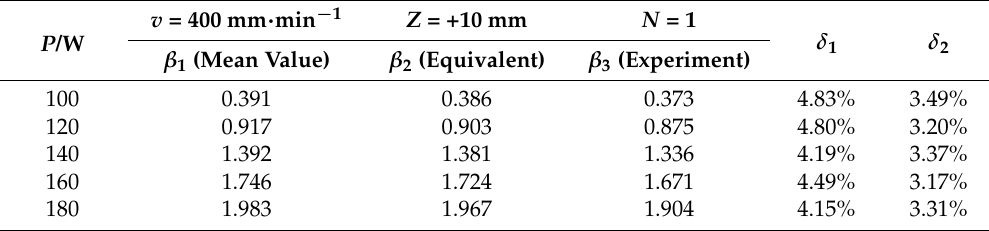
Table 4. Comparison of bending angle and error between the mean value method and the equivalent method with different power.